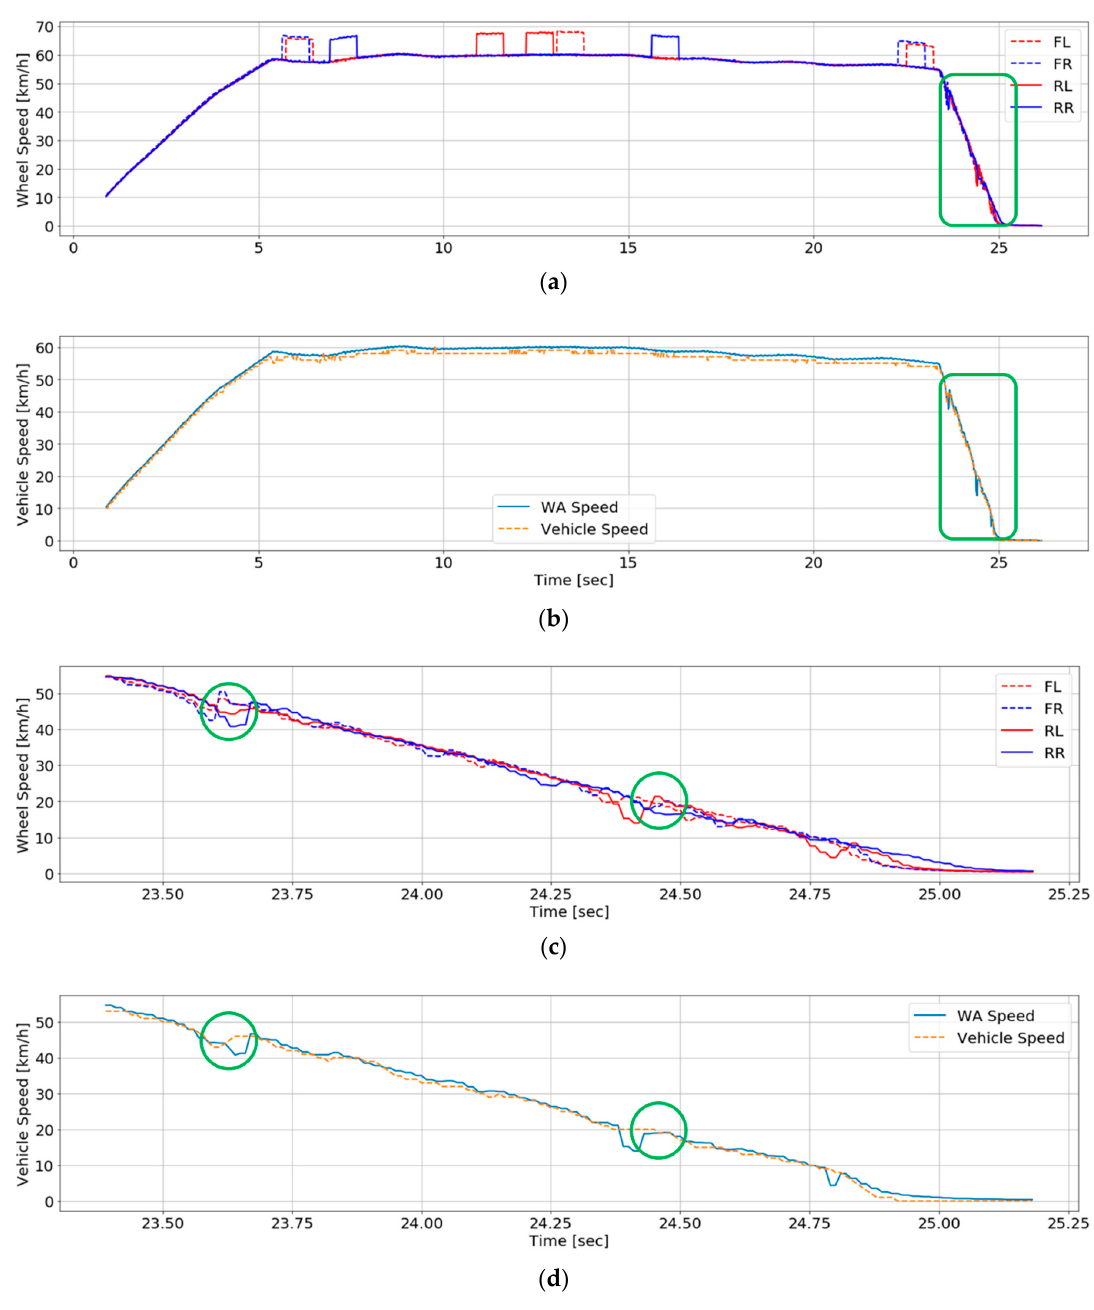
Figure 5. One of the test datasets: ( a ) Test dataset before attack detection; ( b ) The estimated speed after attack detection and speed estimation and the reference speed; ( c ) A part of the test dataset before attack detection; ( d ) A part of the estimated speed after attack detection and speed estimation and the reference speed.